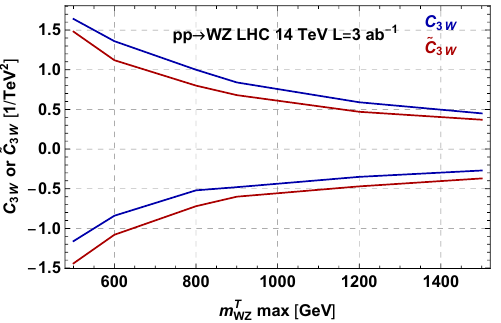
Figure 4 . 95% bound on the c 3 W and ~ c 3 W Wilson coe(cid:14)cients computed with four and two equally spaced angular bins for (cid:30) Z and (cid:30) W respectively, in function of the largest WZ system transverse mass bin used for the 14 TeV LHC with 3000 fb (cid:0) 1 of integrated luminosity. A systematic error of 5% has been